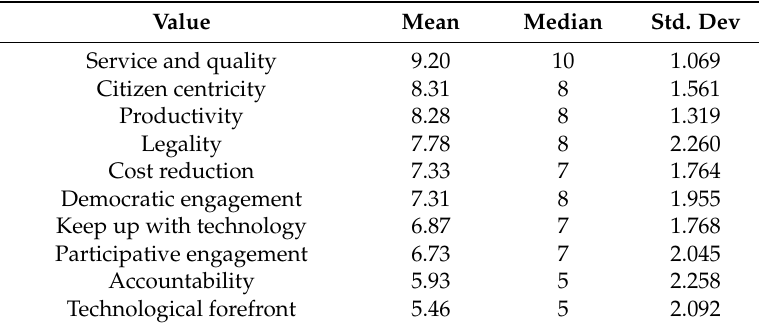
Table 8. Descriptive statistics,